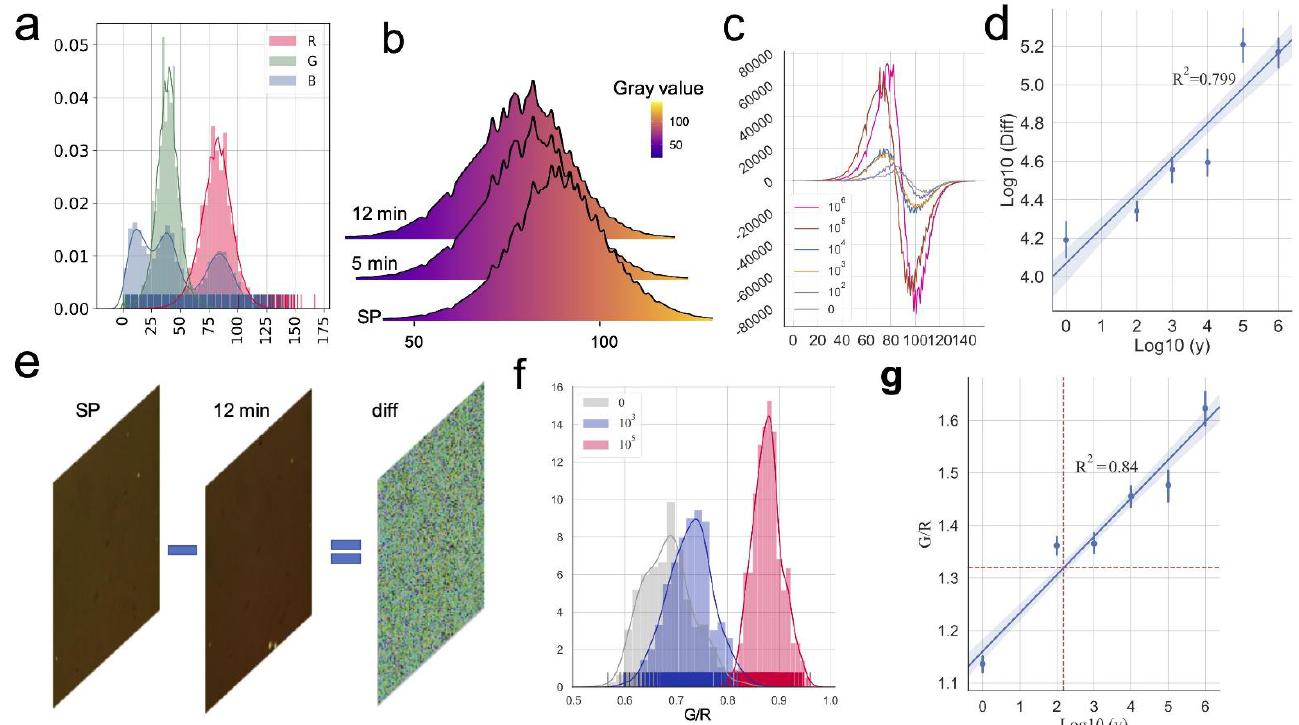
Figure 2. The changes in the gray value of the RGB channels can be used to fit the changes of the SARS-CoV-2 virus concentration. ( a ) The histogram shows the RGB channels gray values count of the chip image after adding the detection antibody. ( b ) The three histograms show the R channel gray values count of chip image at start point (SP), and chip images 5 min and 12 min after adding detection antibody (10 5 vp/mL). ( c ) The figure shows the difference between the 12 min image and the SP image in each gray frequency of the R channel. ( d ) The fitting result of the linear regression model established by the LogDiff of the different SARS-CoV-2 virus concentrations (R 2 = 0.799). ( e ) Schematic diagram of obtaining the median of the difference image. Subtract the two images (SP,12 min) to get the difference image. ( f ) The histogram shows the distribution of ratio of G mean to R mean of all cropped difference images at different virus concentrations. ( g ) The fitting result of the linear regression model established by the G/R ratio of all the sets (R 2 = 0.84) The red dotted line of the y-axis is y blank + 3 σ max, and the red dotted line of the x-axis is